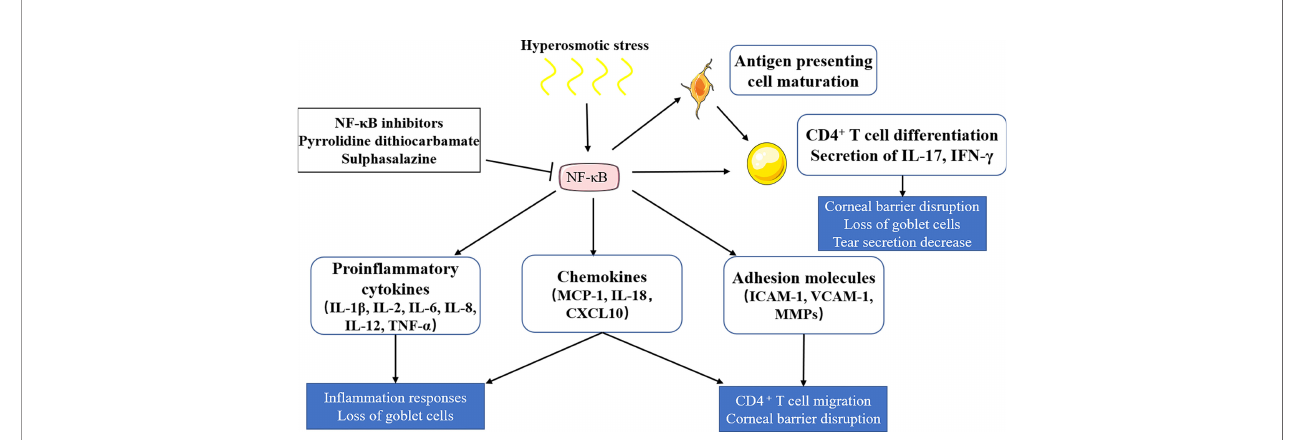
FIGURE 1 | The role of the NF- k B signaling pathway in dry eye. Hyperosmotic stress induces the activation of the NF- k B signaling pathway, which induces the releases of proin fl ammatory cytokines, chemokines and adhesion molecules, and activates antigen-presenting cells and CD4+ T cells. Proin fl ammatory cytokines (IL- 1 b , IL-2, IL-6, IL-8, IL-12, TNF- a ) and chemokines (MCP-1, IL-18, CXCL10) can lead to in fl ammatory responses and goblet cell loss. Chemokines and adhesion molecules (ICAM-1, VCAM-1, MMPs) can induce T cell migration and corneal barrier disruption. CD4+ T cells could be differentiated into T help cells (T H 1 and T H 17), which then release IL-17 and IFN- g , leading to tear secretion reduction, corneal epithelial damage, and goblet cell decrease. NF ‐ k B inhibitors, including pyrrolidine dithiocarbamate and sulphasalazine, show therapeutic potential in dry eye by inhibiting NF ‐ k B activation.